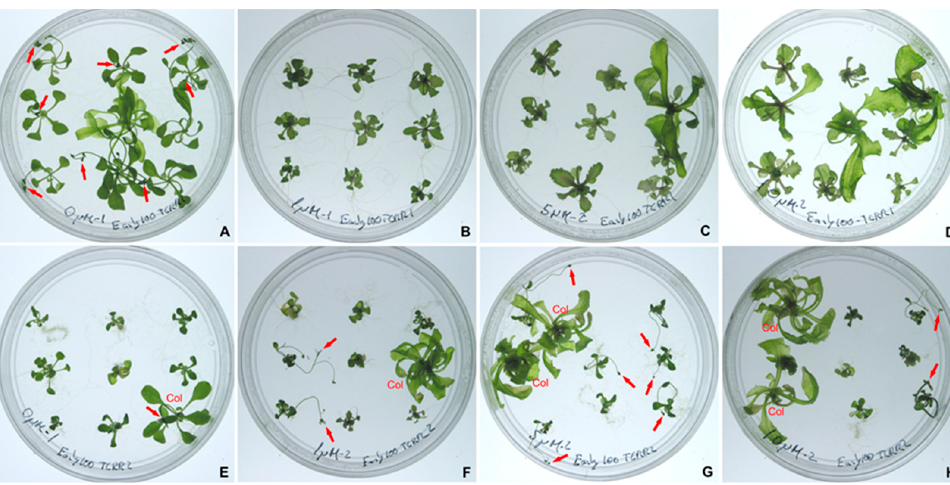
Figure 3. Cytokinin responses in ZmTCRR1 or 2 overexpressing plants. Seven days old primary transgenic plants overexpressing (35Spromoter) ZmTCRR1 ( A – D ) or ZmTCRR2 ( E – H ) were cultured in MS media containing 0 µM ( A , E ), 1 µM ( B , F ), 5 µM ( C , G ) or ( D , H ) 10 µM BA for 16 days. Some plants were found non-transgenic by DNA genotyping and thus labelled as Col (Columbia) in the figure. Arrows point to flower buds. The plates are 90 mm diameter Petri dishes.